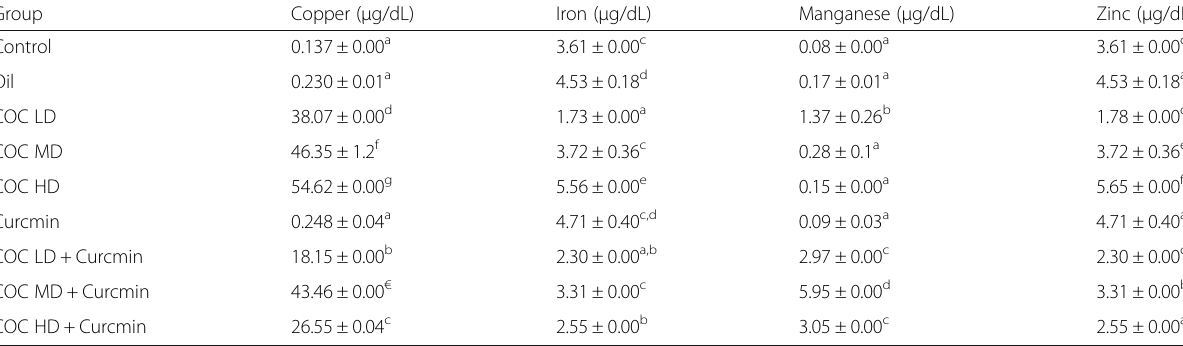
Table 3 Effects of COC and curcumin on hepatic trace element in rats